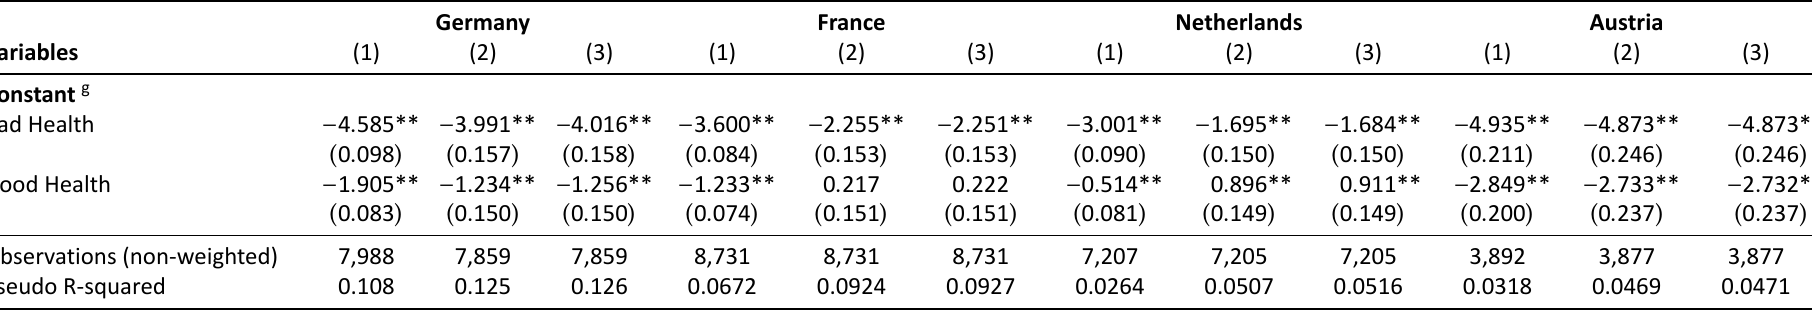
Table 2. (Cont.) Ordered regression predicting good general health status by country of destination (dependent variable is self-perceived health , 1–3, 3 = very good health).